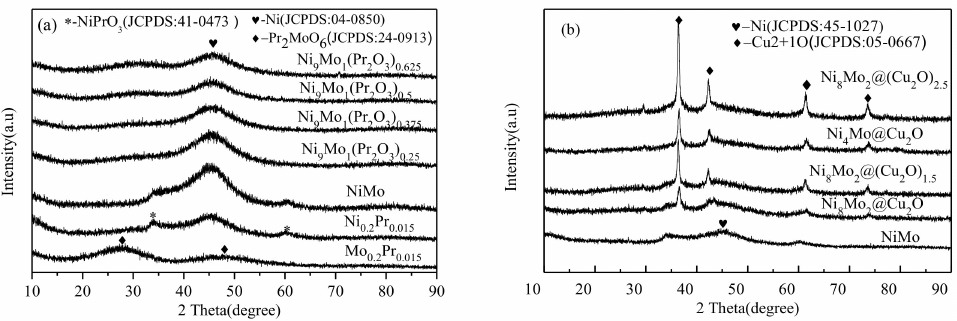
Figure 1. ( a ) XRD patterns of Ni 9 Mo 1 (Pr 2 O 3 ) y (y = 0, 0.25, 0.375, 0.5, 0.6125) and Ni 0.2 Pr 0.15 and Mo 0.2 Pr 0.15 catalyst samples. ( b ) XRD patterns of Ni 4 Mo@(Cu 2 O) y (y = 0, 1, 1.5, 2, 2.5) catalyst